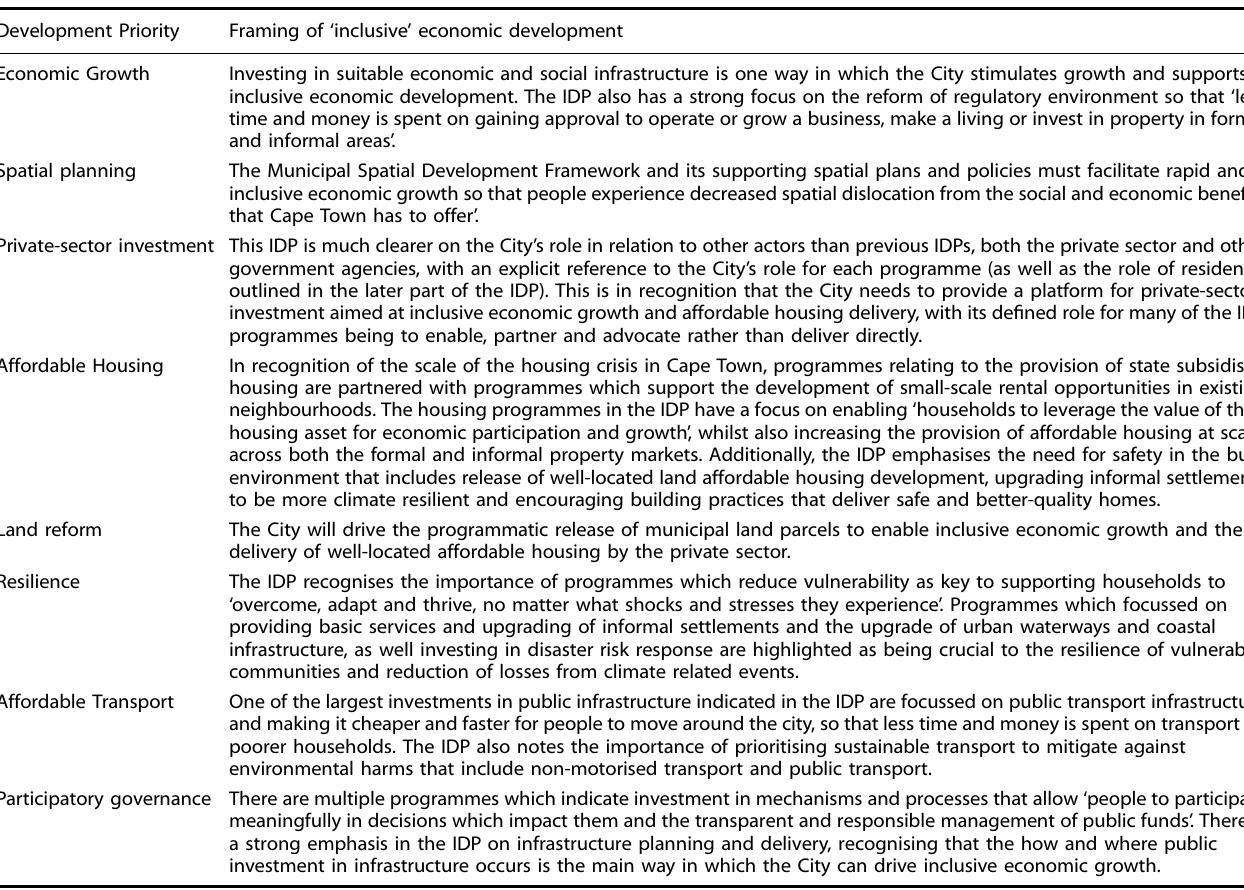
Table 3. Key development priorities and framings of inclusive economic development in the City of Cape Town ’ s Integrated Development Plan 2022 – 2027 5